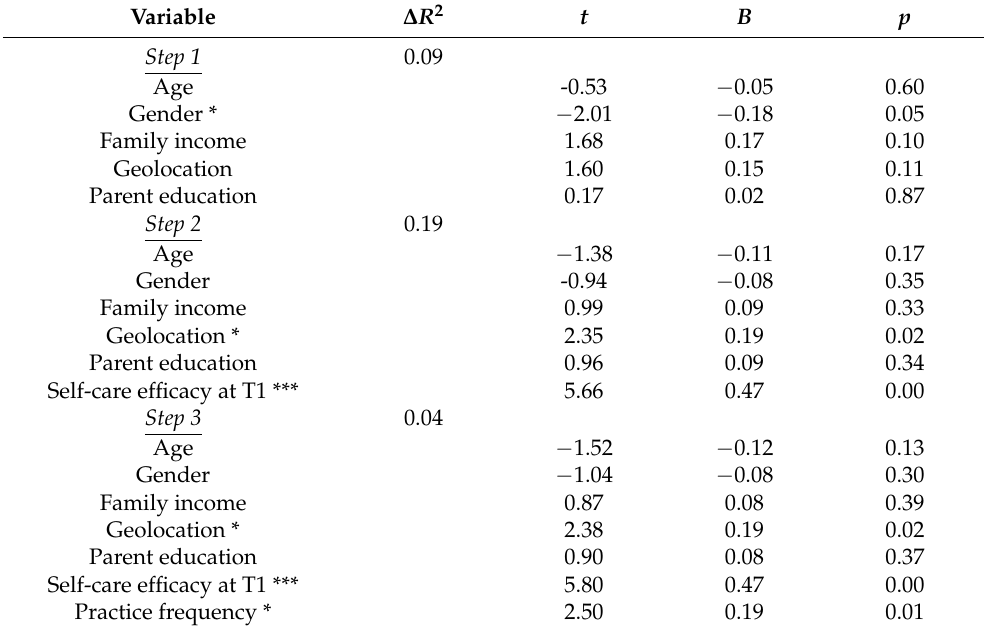
Table 6. Hierarchical regression estimates predicting self-care efficacy at T2.